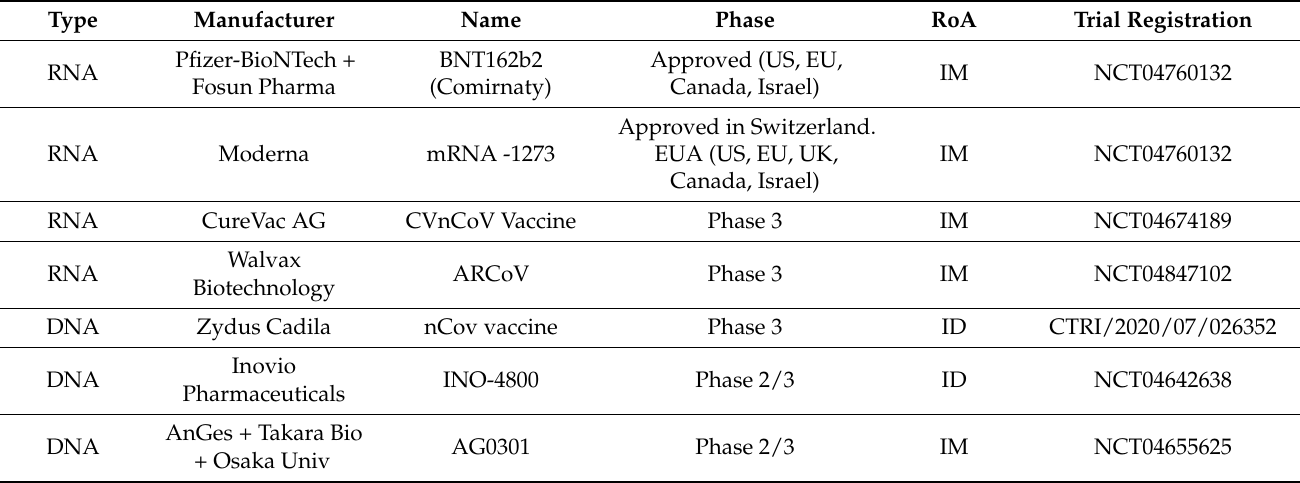
Table 2. Promising COVID-19 Nucleic Acid-based Vaccine candidates in clinical